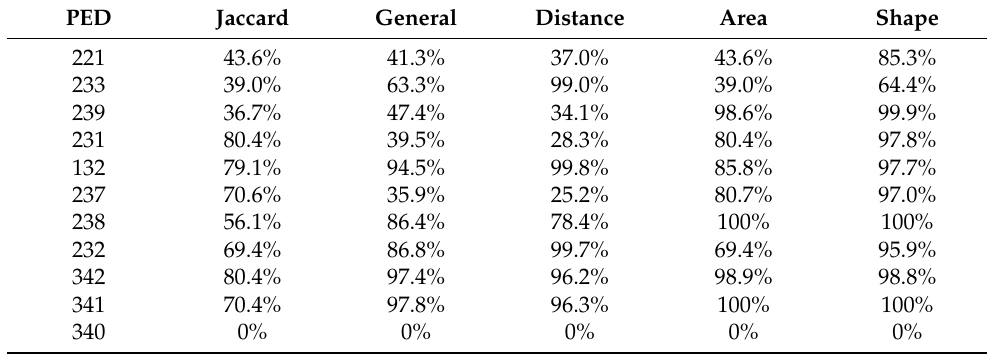
Table 1. The rectangular similarity and the Jaccard index for pedestrians detected in Figure